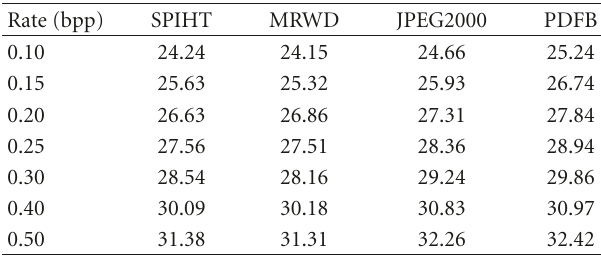
Table 1: Performance comparison (PSNR [dB]) for Barbara.